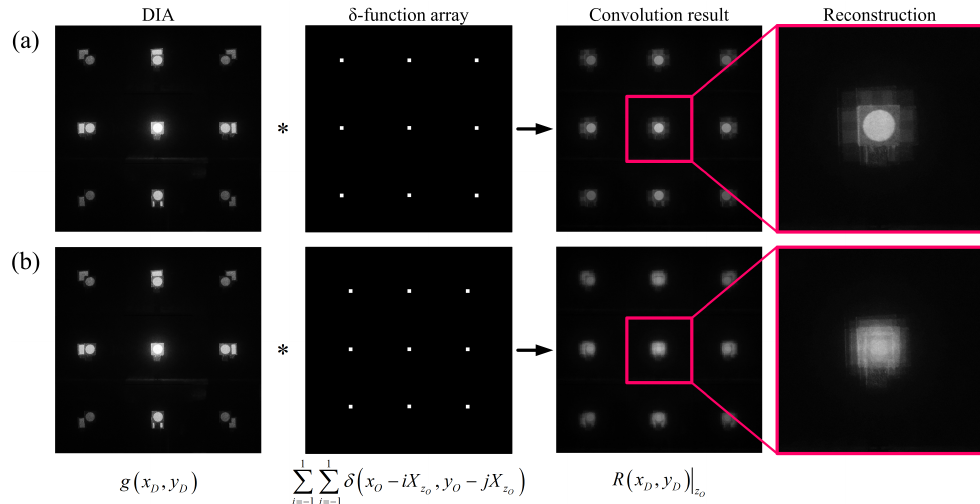
Figure 2. Computational reconstruction through convolution of DIA and δ -function arrays in diffrac- tion grating imaging. ( a ) Reconstruction result when the spatial period of the δ -function array coincides with the spatial period at the object’s depth; ( b ) Reconstruction result when the spatial period at the object’s depth and that of the δ -function array do not match each other.